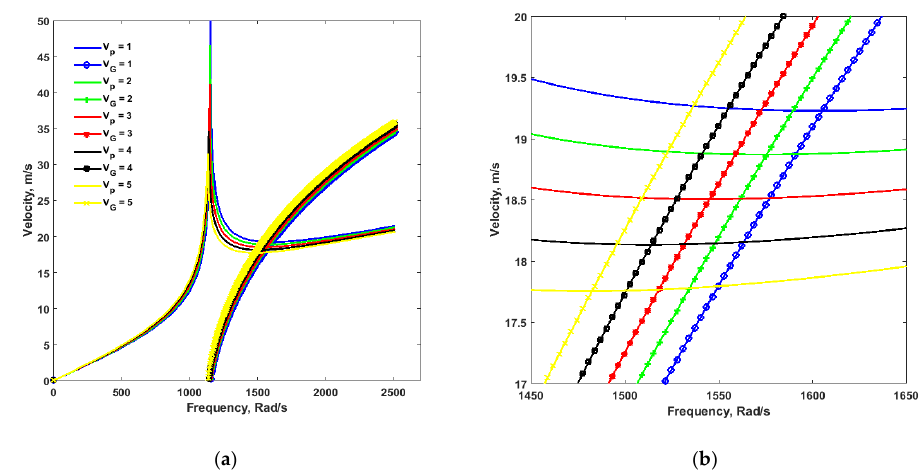
N/m/m. ( b ) Close View of 6 10